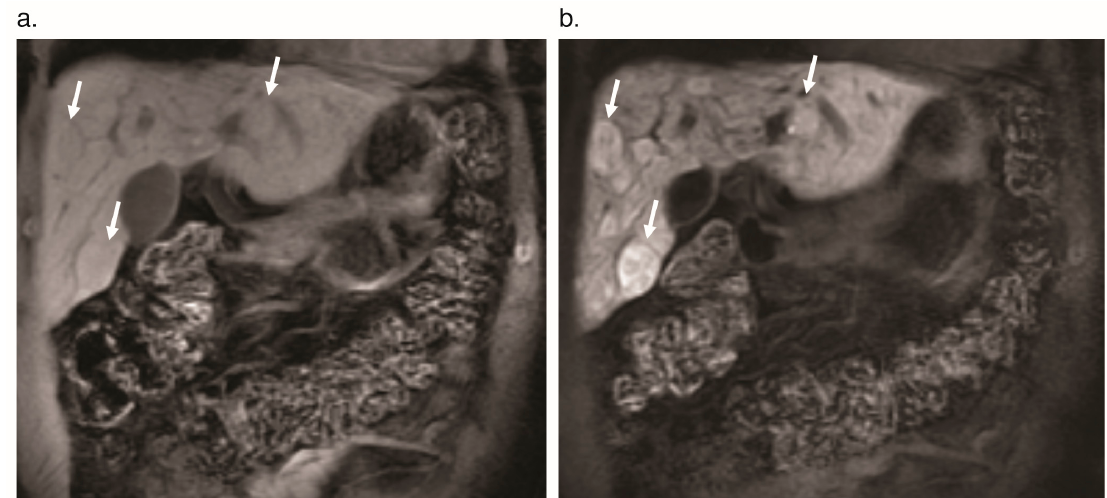
Figure 9. Focal nodular hyperplasia (FNH) in a 61-year-old woman with HHT. ( a ) Numerous hepatic lesions (arrows) are essentially imperceptible given signal characteristics similar to that of background parenchyma on pre-contrast-enhanced coronal T 1 -weighted MR image. ( b ) The lesions (arrows) are hyper-enhancing on the hepatobiliary phase of the gadoxetate-enhanced coronal T 1 -weighted MR image due to expected retention of contrast, compatible with multifocal FNH.